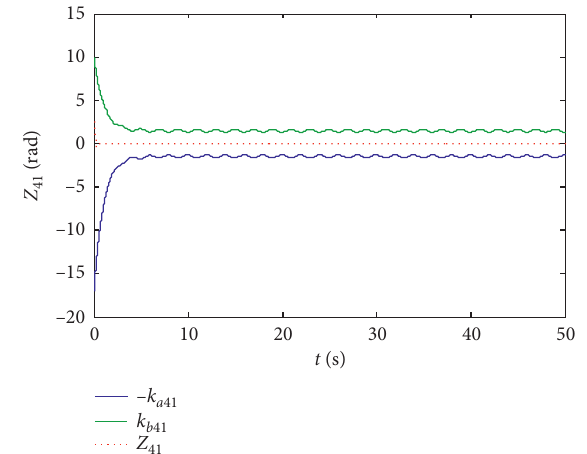
Figure 24: Constraint effect of Z